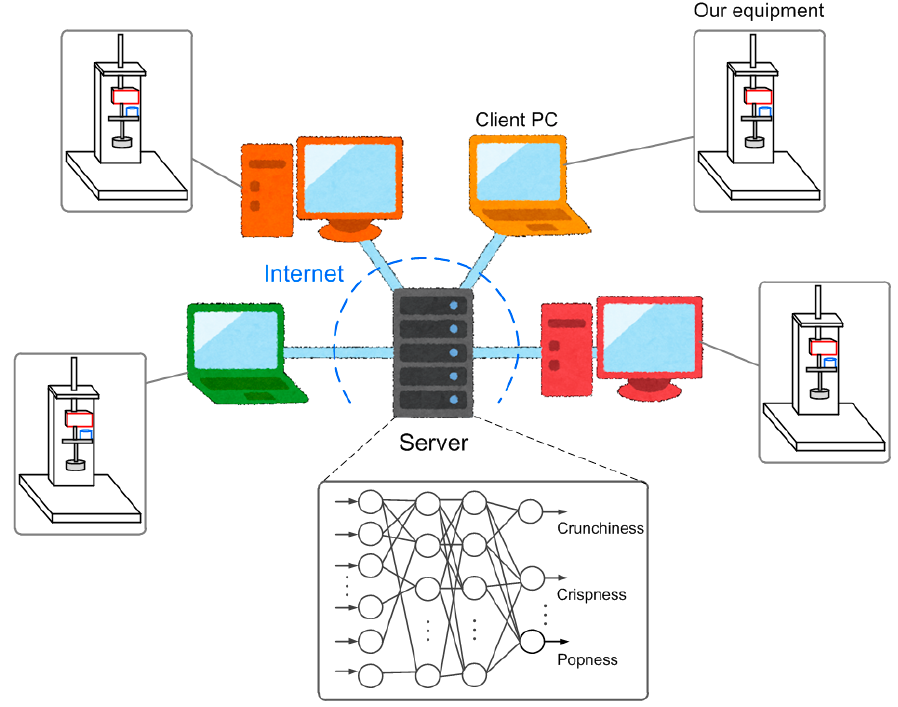
Figure 3. Schematic of the proposed system connected to the internet.